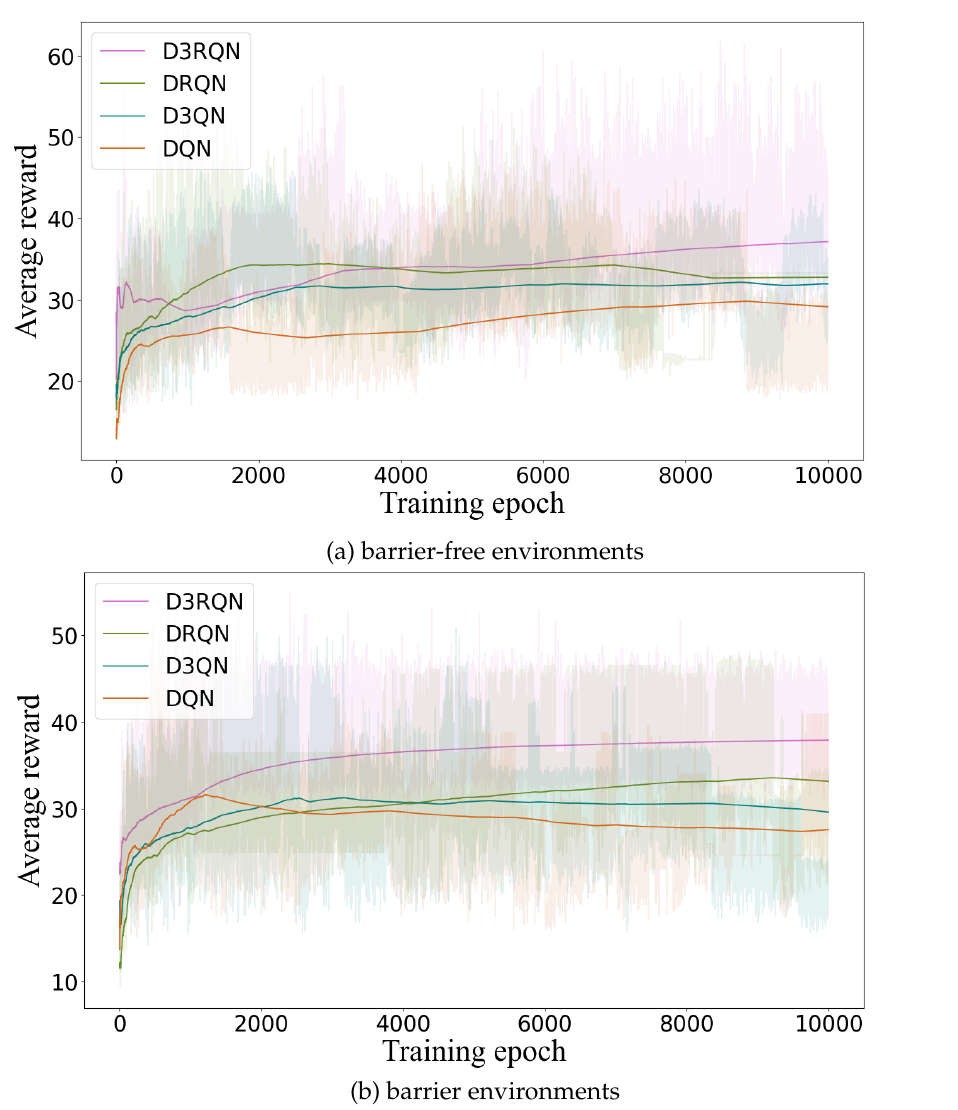
Figure 5. Comparison of the experimental results of a single observation platform. ( a , b ) Comparison of the reward functions of DQN, D3QN, DRQN, and D3RQN running in barrier and barrier-free environments,